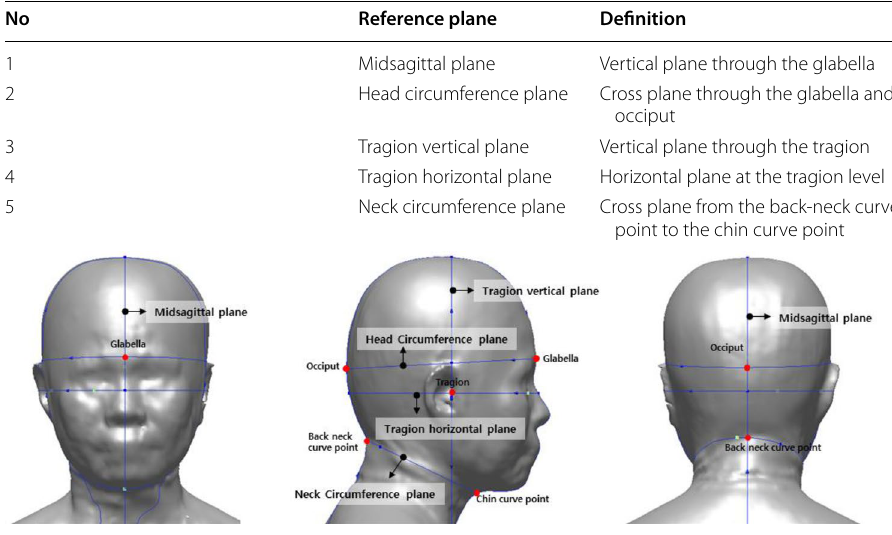
Italic values indicate group with high frequency